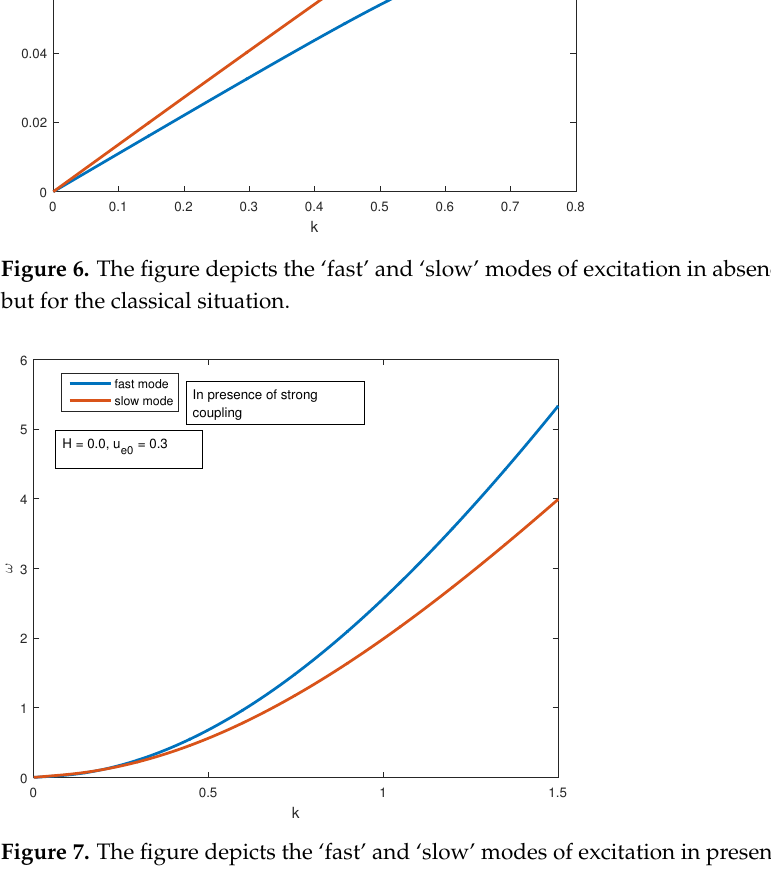
Figure 7. The figure depicts the ‘fast’ and ‘slow’ modes of excitation in presence of strong coupling but for the classical situation.